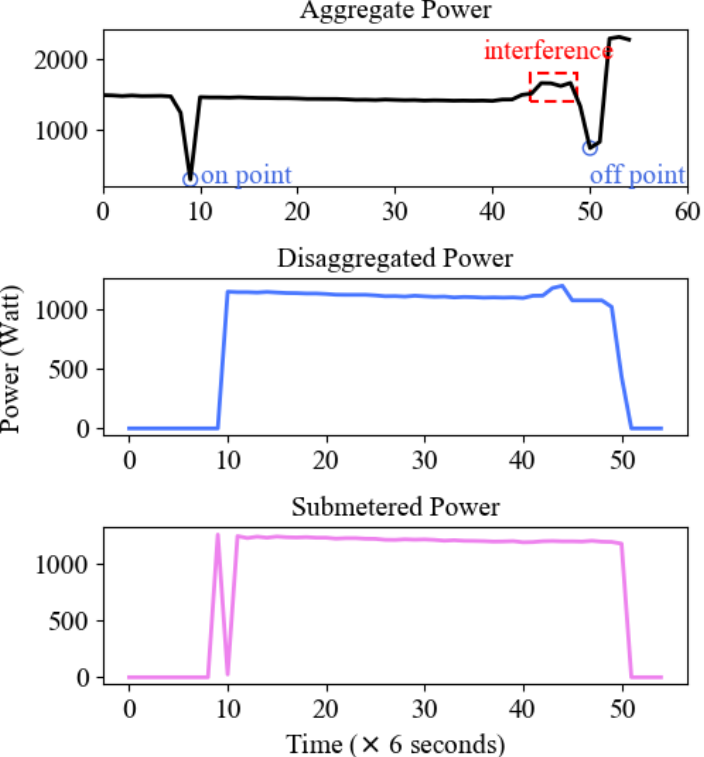
Figure 8. An example of energy disaggregation. The red dashed box stands for interference from other appliances. The blue circle stands for on/off points of an operation